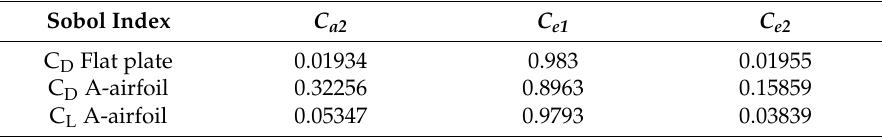
Table 10. Sobol index of three model coefficients for point-collocation